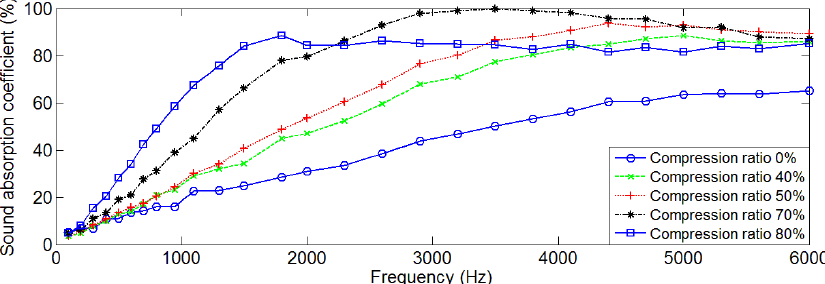
Figure 5. Comparisons of sound absorption coefficients of the samples with same thickness of 15 mm.